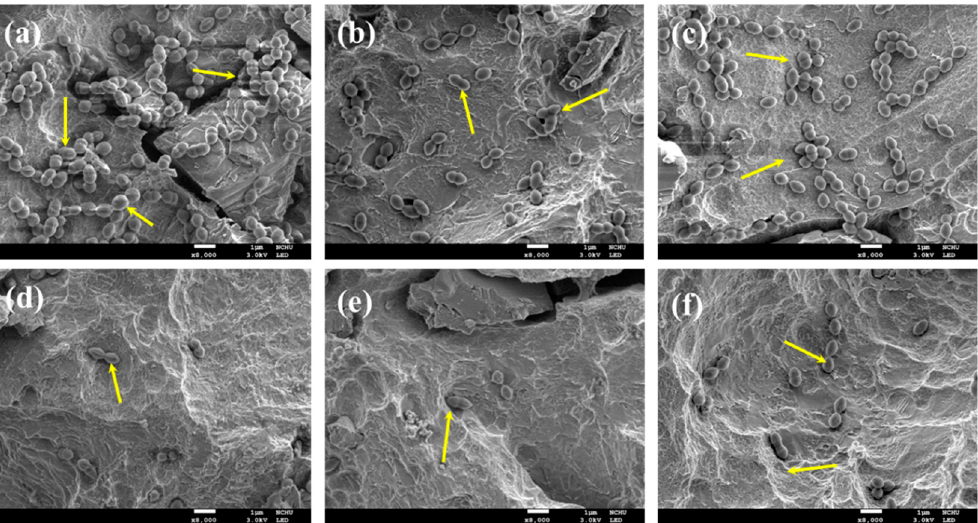
Figure 6. SEM images of the S. mutans -contaminated SLA Ti alloy surfaces ( a ) before and after treatment with ( b ) QTS1 alone, ( c ) MB100 alone, ( d ) MB100-PACT, ( e ) QTS1 + MB100-PACT, and ( f ) MC1 + MB100-PACT. The arrows indicated the presence of bacteria. The arrows indicate the presence of bacteria.